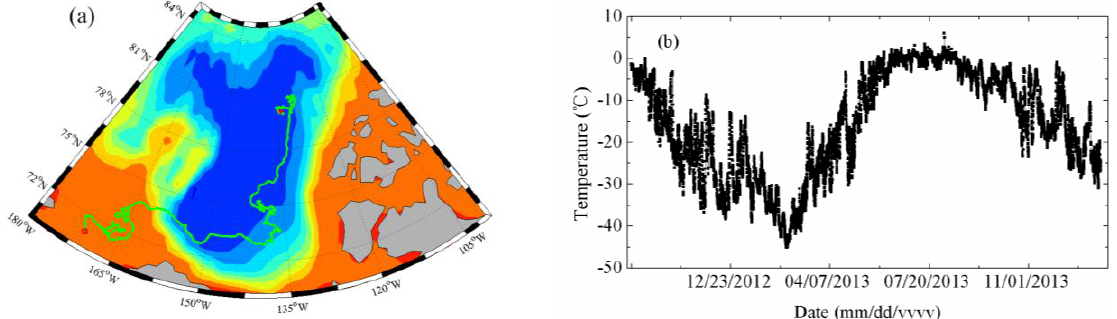
Figure 4. ( a ) Drift trajectory (green line) of an Ice Mass-Balance buoy from 10 September 2012 to 16 January 2014 in the Arctic Ocean. ( b ) Air temperature measured by the buoy.